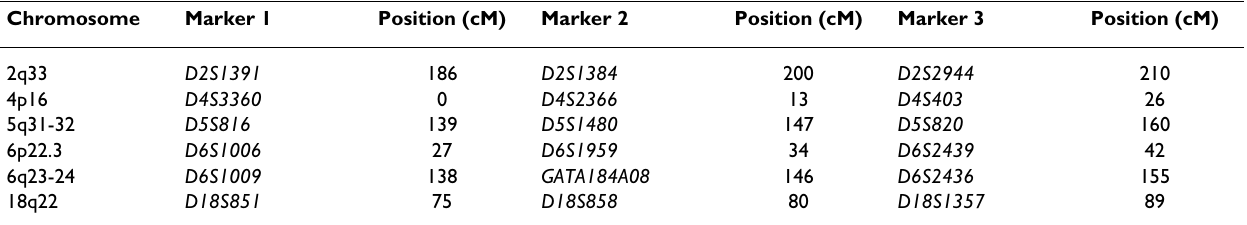
Table 2: Eighteen microsatellite markers genotyped, three at each of the six loci, for Follow-up study. Marker 2 is the peak marker in original study at each locus. Chromosome